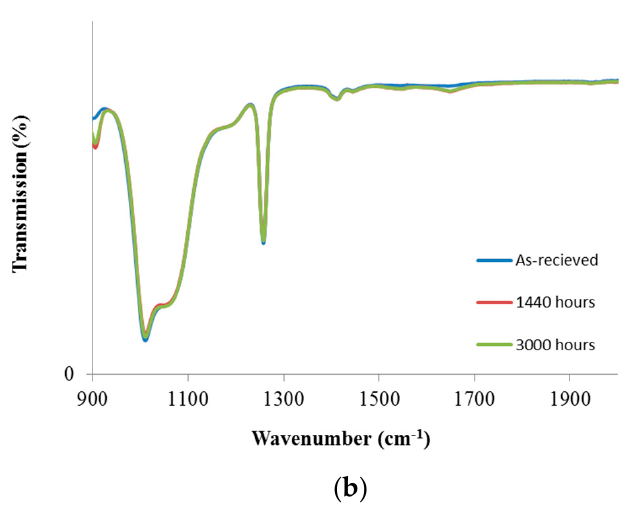
Figure 2. FTIR-ATR spectra of ( a ) UV at 35 °C, and ( b ) blue-light exposed at 100 °C.